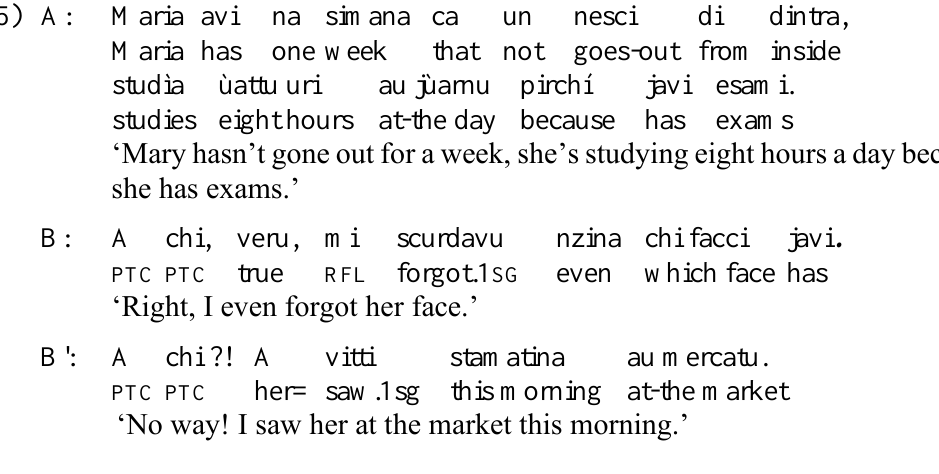
Figure 3. A chi in (35B) (one speaker) Figure 4. A chi in (35B´ (one